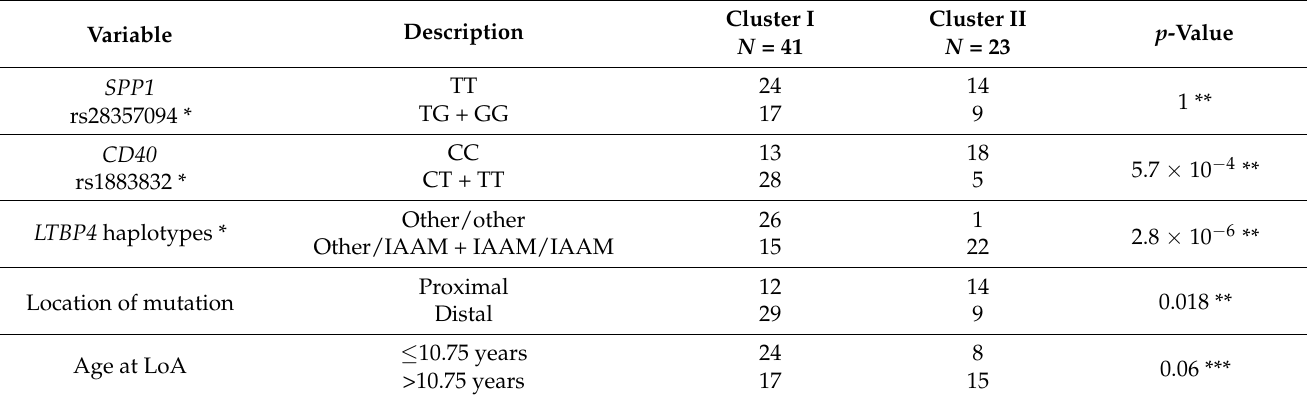
Table 3. Cluster profiles of non-ambulant DMD patients according to genetic factors and age at loss of ambulation